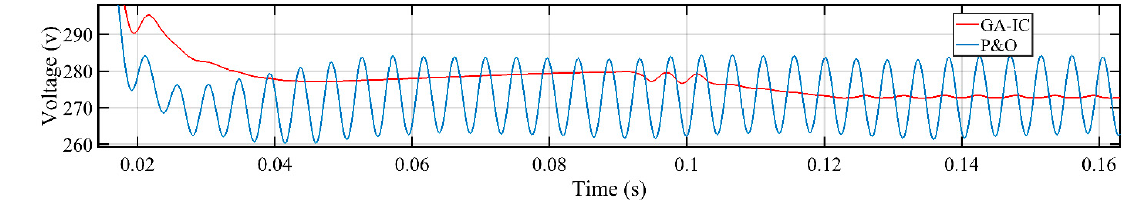
Figure 27. Case 2 voltage, detailed comparison of modified GA-IC vs. P&O.